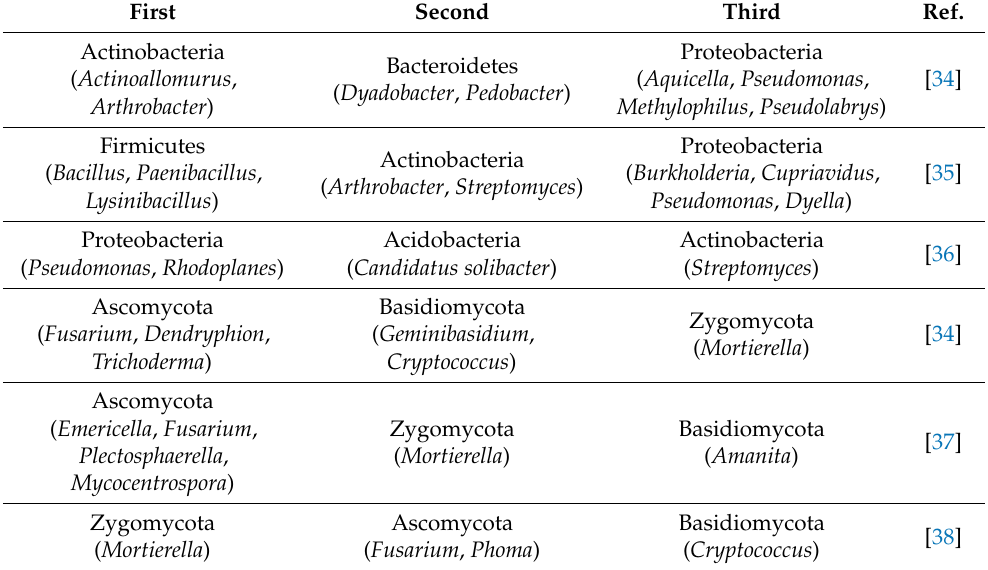
Table 1. Examples of studies of bacterial and fungal rhizobiome diversity in P. notoginseng . The first most dominant phylum followed by the second and third most dominant phyla are listed with common genera within each phylum in parentheses when